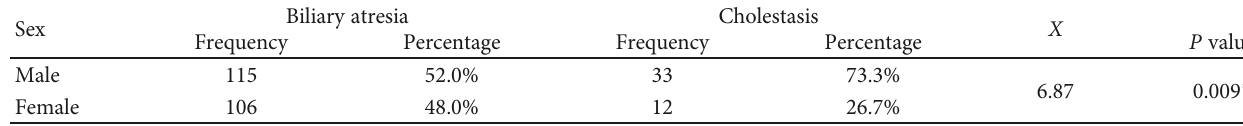
Table 1: Sex of patients with biliary atresia and patients with